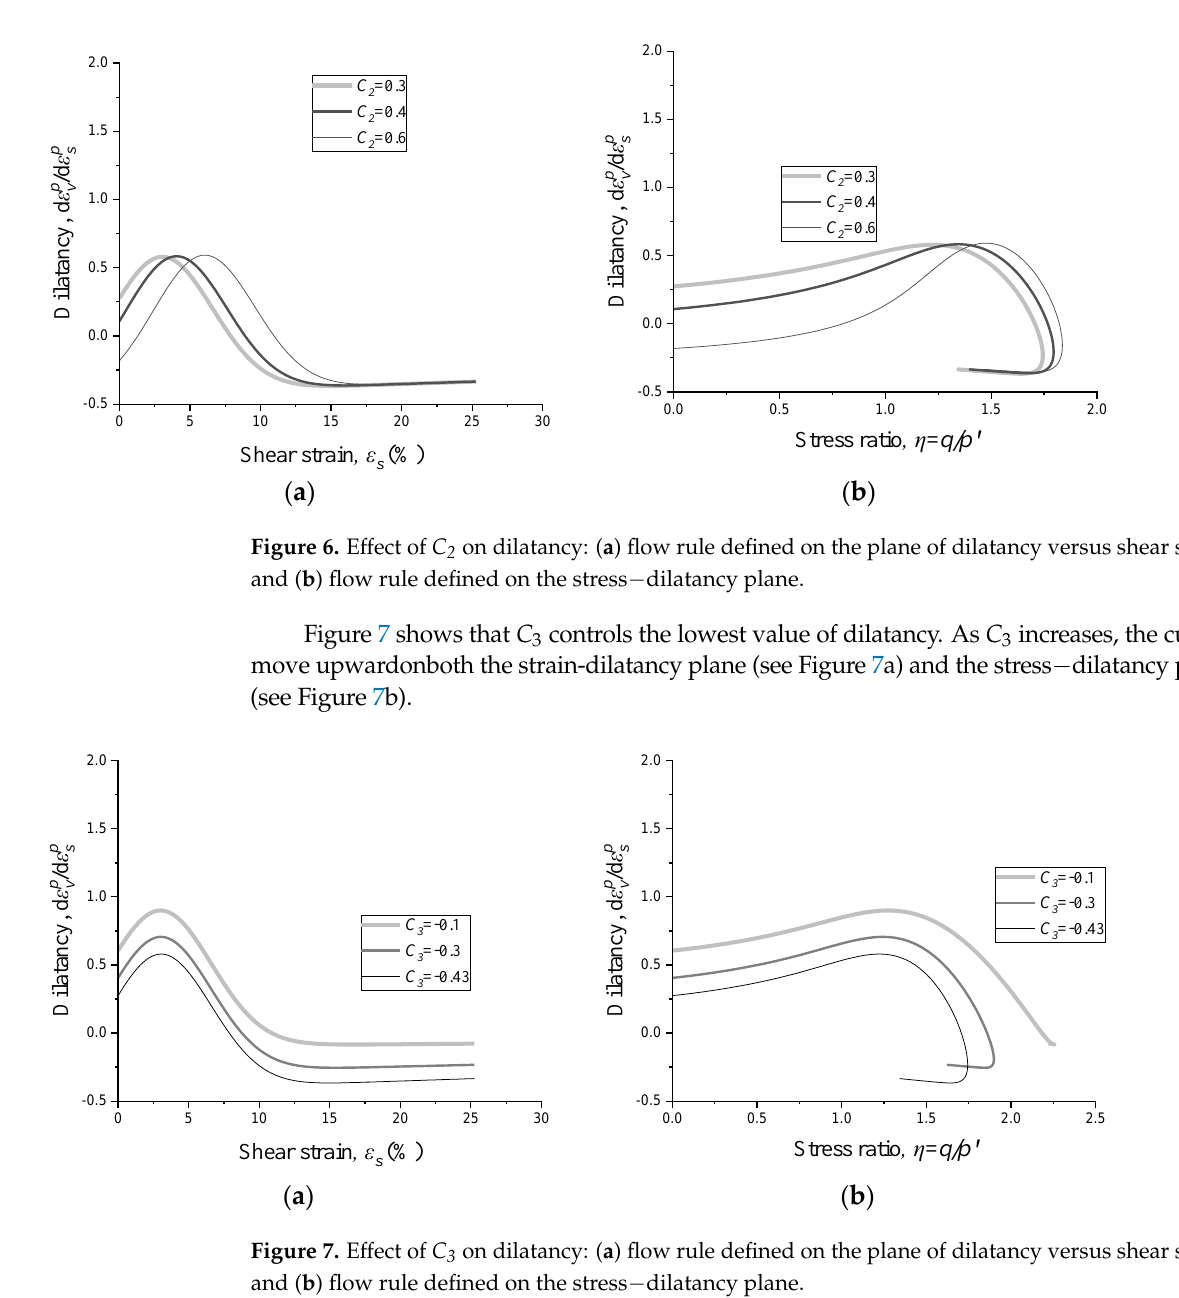
Figure 7. Effect of C 3 on dilatancy: ( a ) flow rule defined on the plane of dilatancy versus shear strain, and ( b ) flow rule defined on the stress − dilatancy plane.